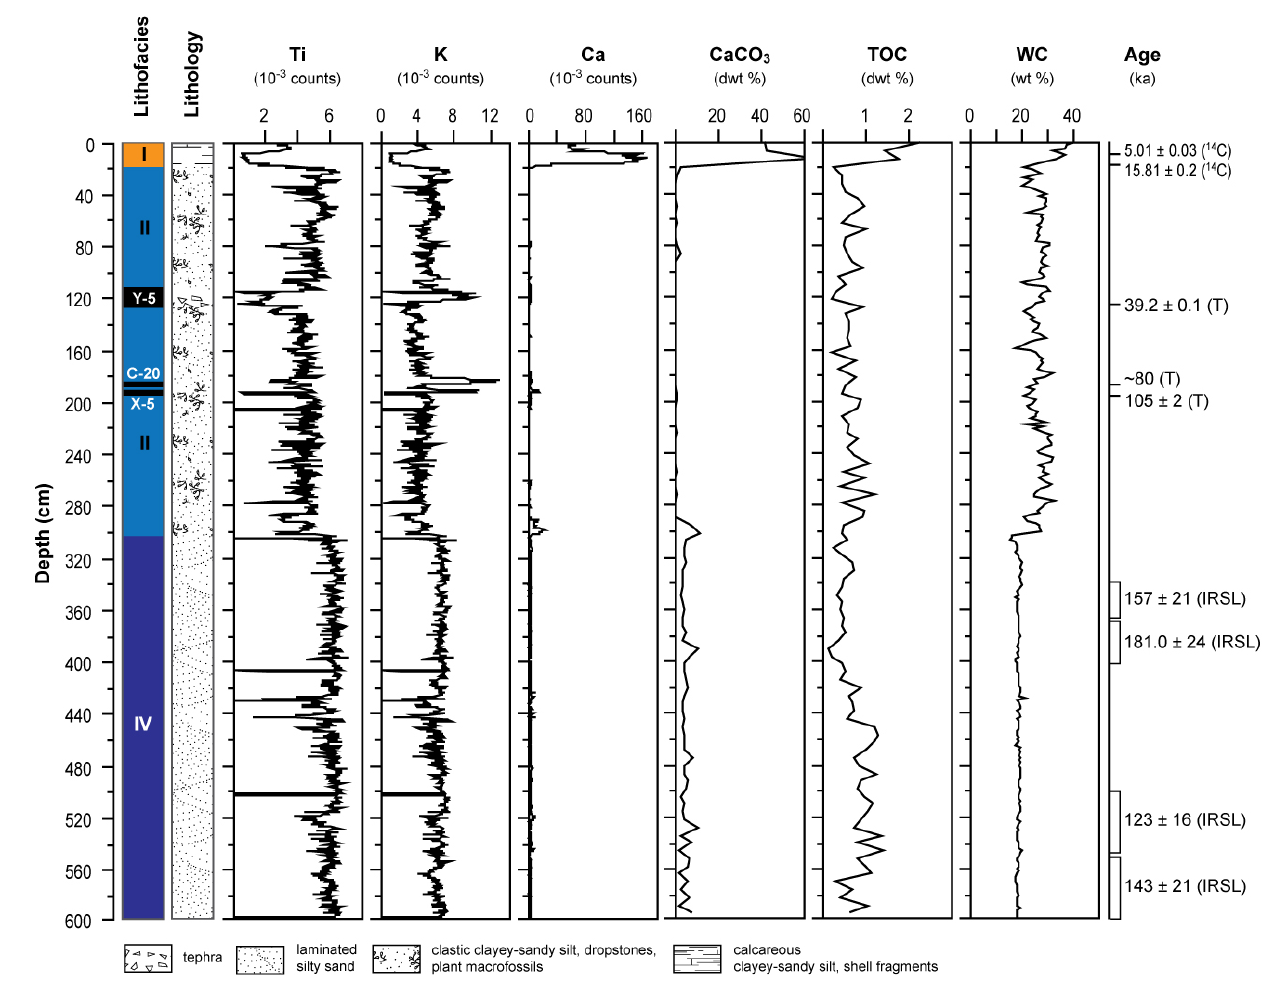
Fig. 6. Lithofacies, lithology, Ti-, K- , Ca- intensities, CaCO 3 , total organic carbon (TOC) dry weight percentages, water content (WC), and age control points of core Co1201. 14 C=calibrated radiocarbon age, T=tephra age, IRSL=infrared stimulated luminescence age. Location of core is shown on Figs. 3 and 4.